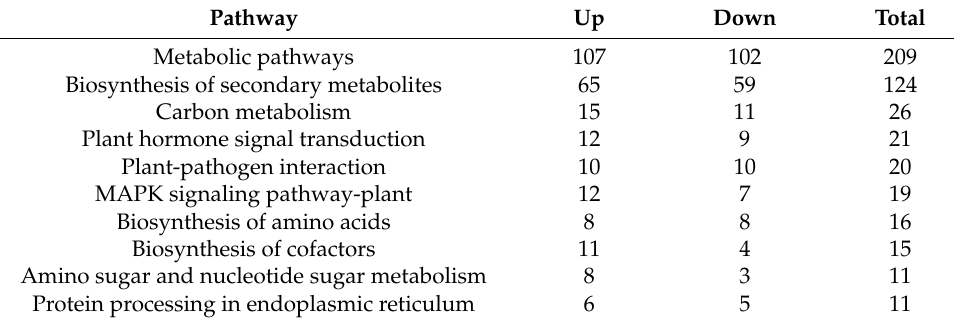
Table 1. Top 10 pathways enriched in the “H 2 O1h vs. MgO1h” group.